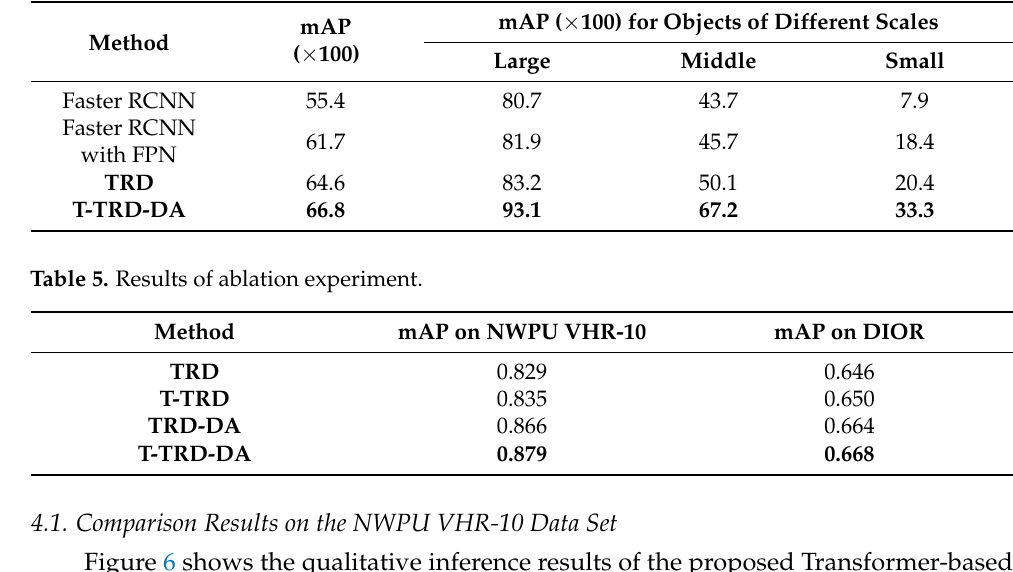
Table 4. Results for objects in specific scale ranges from the DIOR data set.